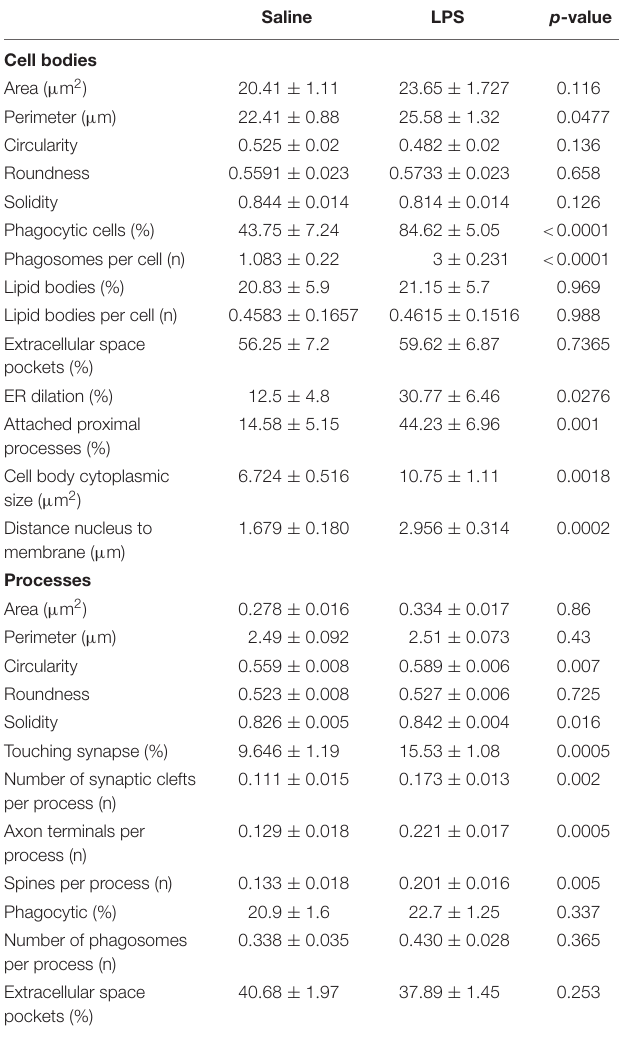
TABLE 1 | Quantification of ultrastructural changes induced by LPS in 4 month old